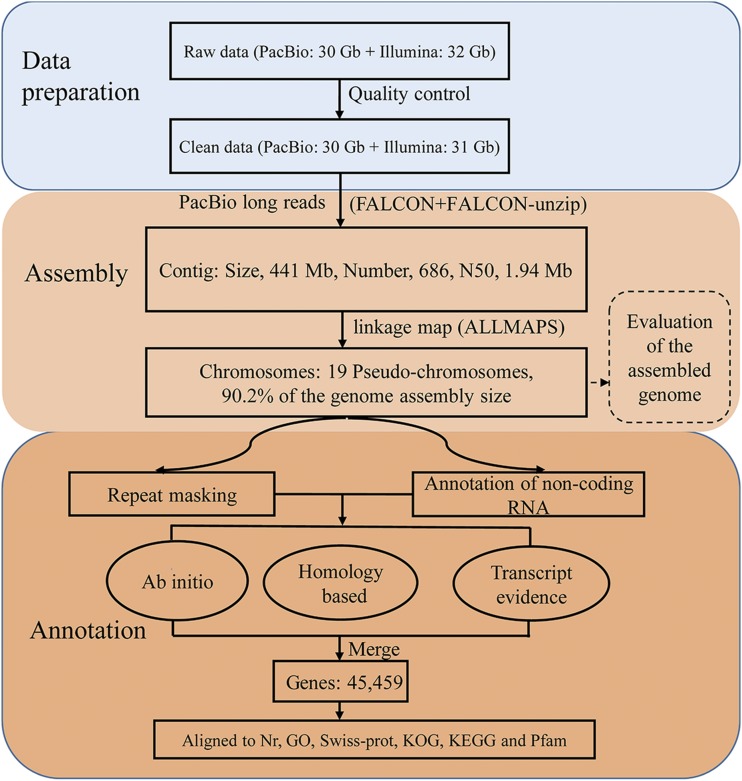
Integrated work-flow for sequencing, assembly and annotation of the Populus simonii genome.